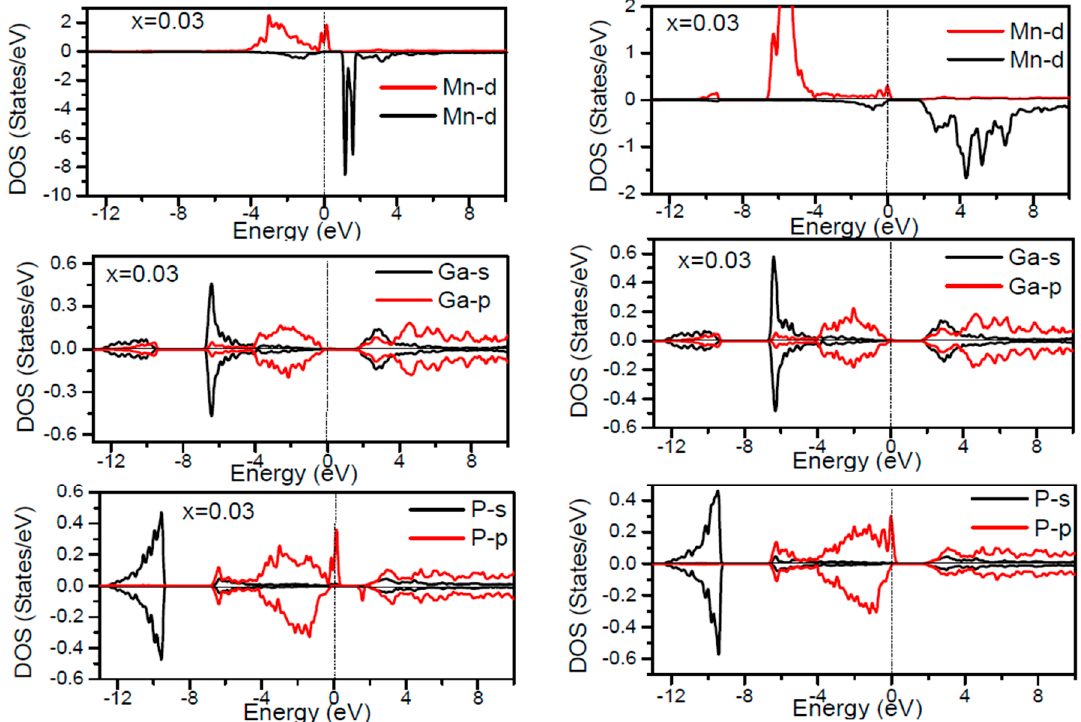
Figure 3. Computed partial DOS of spin polarized contributions from Ga-s,p, As-s,p, and Mn-d states in the Ga 1 − x MnP ( x = 0.03) alloys for spin up and spin down. The left panel indicates the GGA calculations and right panel denotes the GGA + U calculations. The vertical dash line denotes the Fermi level.